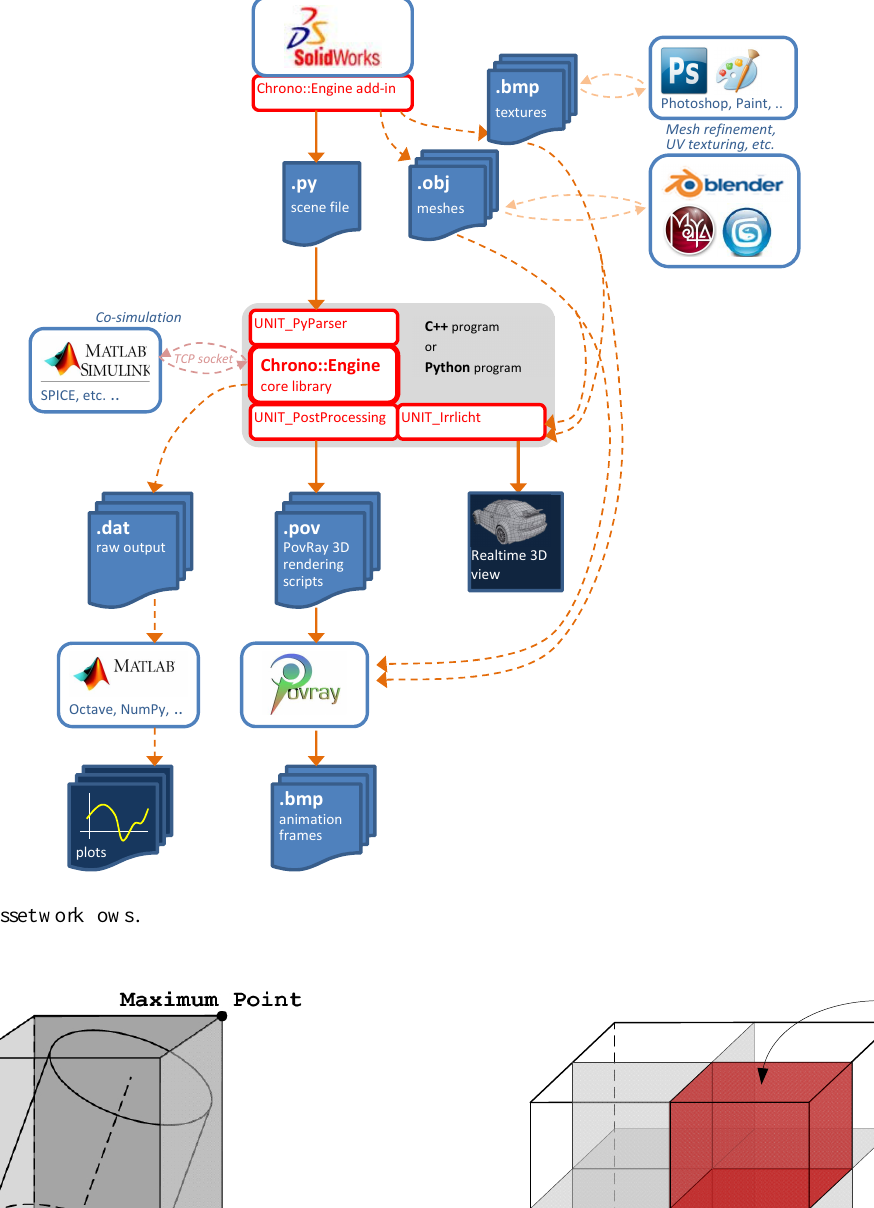
graph between classes: example for ChBody and ChSystem . Figure 3 : Collaboration